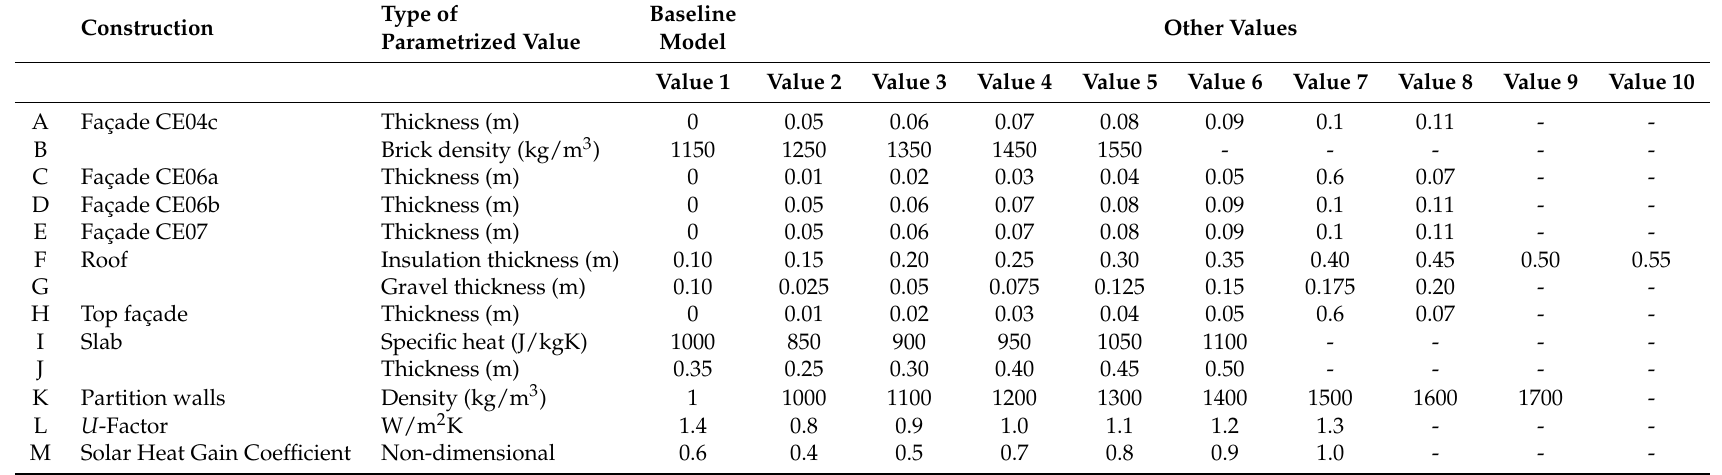
Table 1. Search space for the genetic